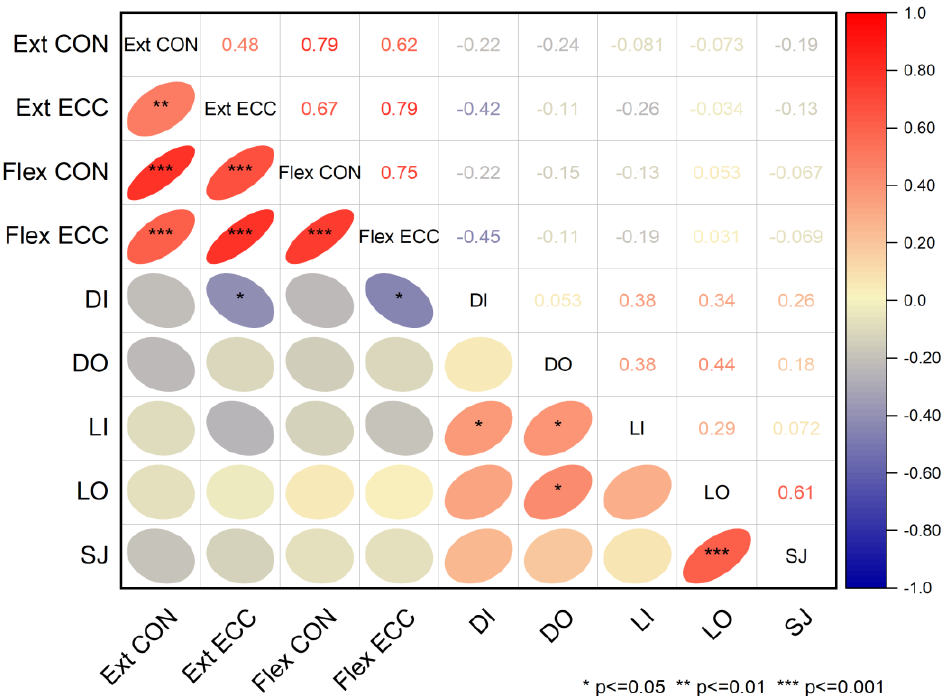
Figure 3. Spearman rank correlation for multidirectional TTS and normalised isokinetic peak torque values. Correlation coefficients are shown in the top-right corner; correlation ellipses and significance are shown in the bottom-left corner. Positive correlations are red-shifted, and negative correlations are blue-shifted on the colour spectrum. Ext = extensor; flex = flexor; CON = concentric; ECC = eccentric; DI = diagonal inside; DO = diagonal outside; LI = lateral inside; LO = lateral outside; SJ = straight jump.